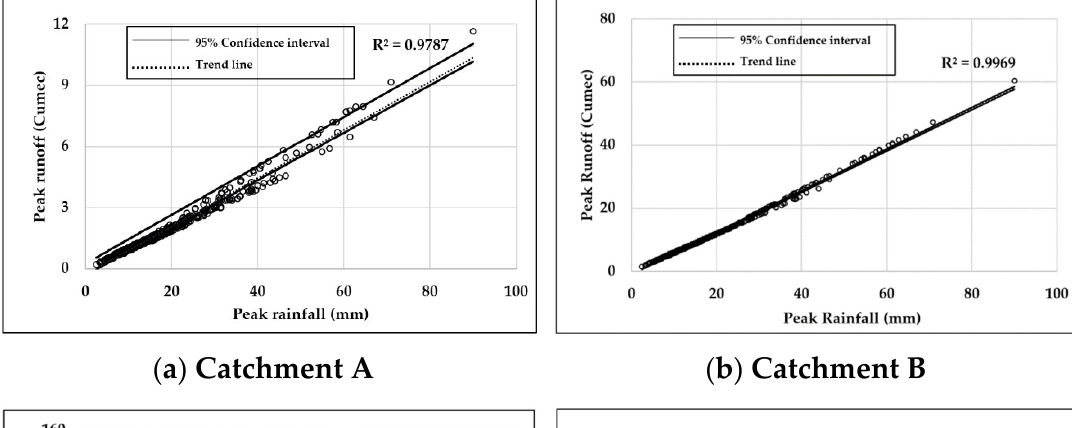
Table 3. Results of regression analysis between peak rainfall and peak runoff in urban catchments. Catchment